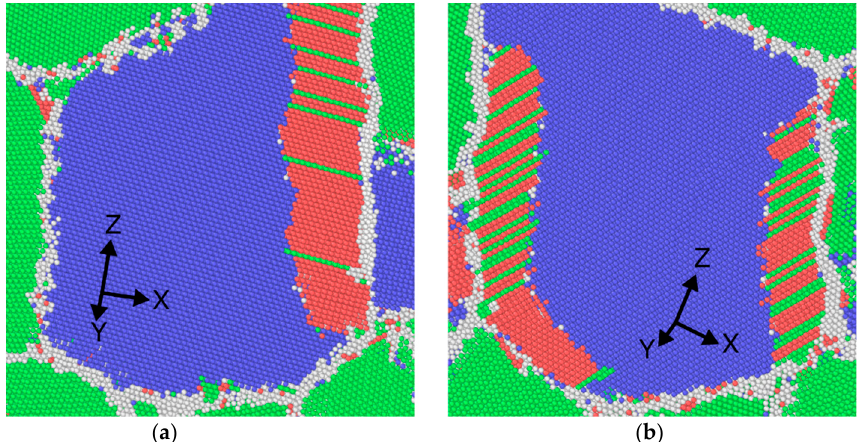
Figure 5. Cross-sections of a bcc lamellae by the ( 1(cid:3364) 10) plane parallel to the bcc/fcc interface in two different medium grains with one ( a ) and two ( b ) fcc/hcp bands at the strain 3.00%. Atoms with bcc, fcc, hcp and uncertain nearest neighbor symmetry are shown in blue, green, red, and light grey, respectively.